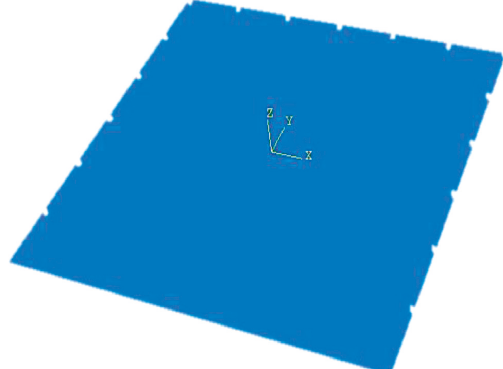
Figure 5: Plate loading and applied support